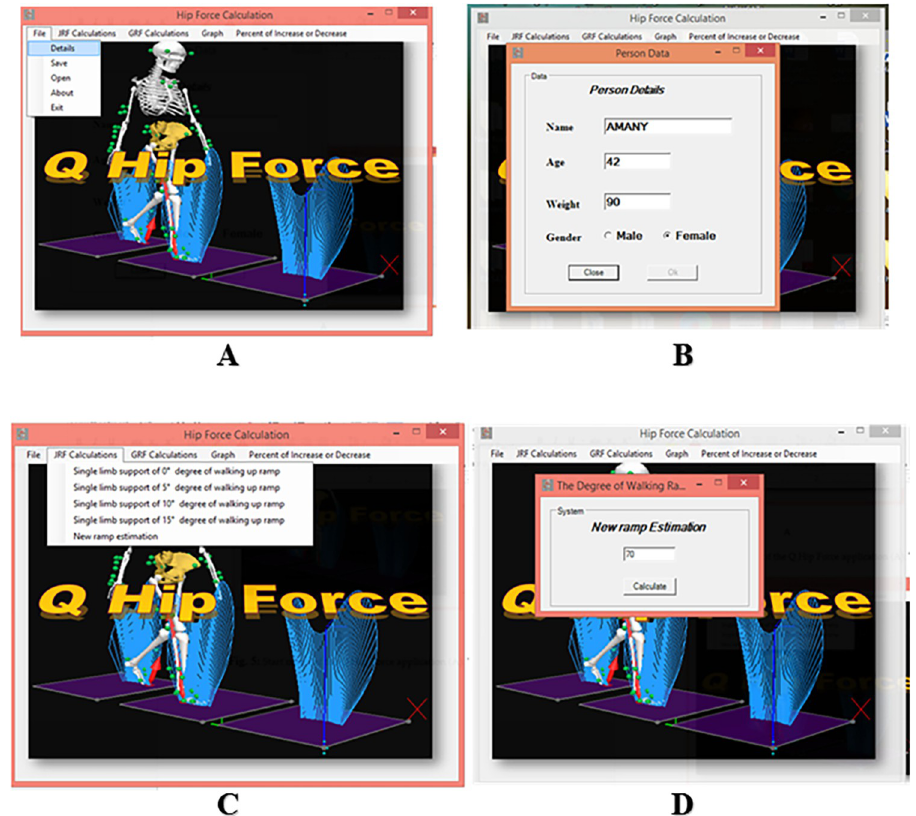
Fig 6. Hip force calculation through AQHF. (A) The start menu of the AQHF Application. The hip force calculation can be done through the Q hip force start window. All functions in the software can be reached through the start menu. The File > detail option is selected. (B) This displays the Person Data menu. The relevant subject data is entered, and the files used as input for the analysis are selected. (C) Calculation for 0,5,10 and15 degrees ramps is done through this window. (D) New ramp estimation that can calculate up to elevation of 70 degrees.